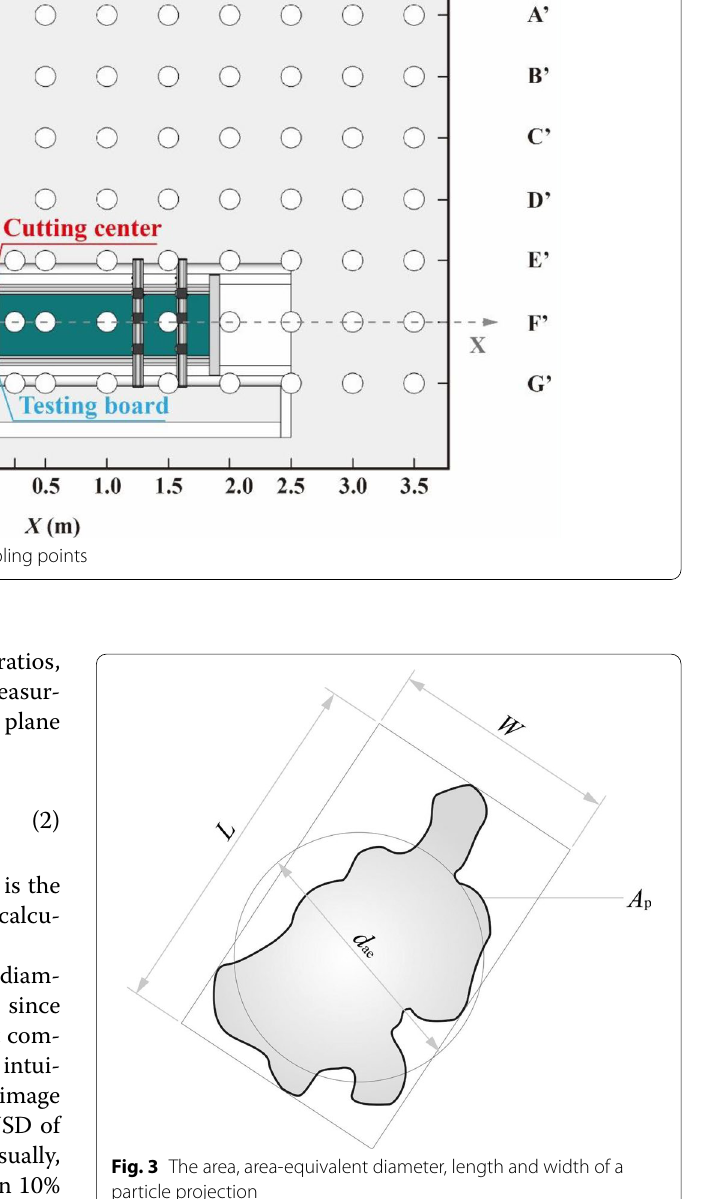
larger length-to-width ratio. The particles with higher elongation have greater internal cohesion, resulting in the increase of the ability to resist external shear force and the decrease of flowability [25]. To describe particle